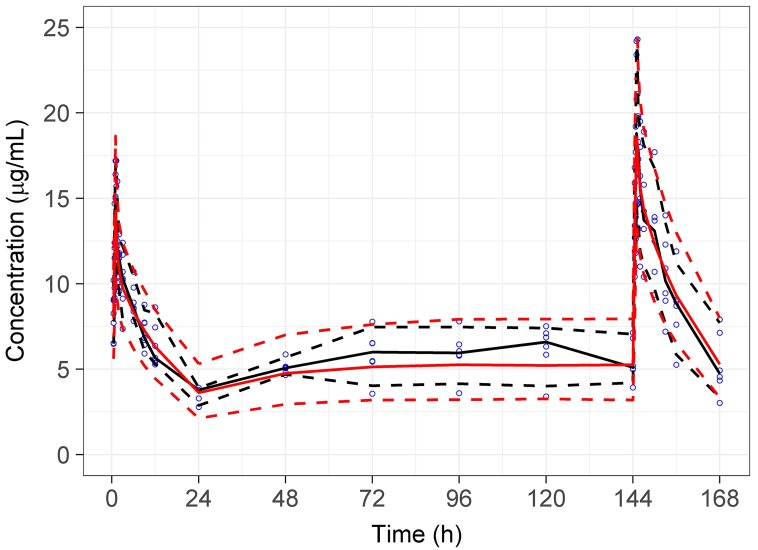
Visual predictive check plot for 1000 simulations of the final pharmacokinetic model and observed data.Solid lines are the median and dashed lines represent the upper and lower confidence intervals of the observed data (black) and prediction intervals of the final model (red). Circles are the raw observed data.